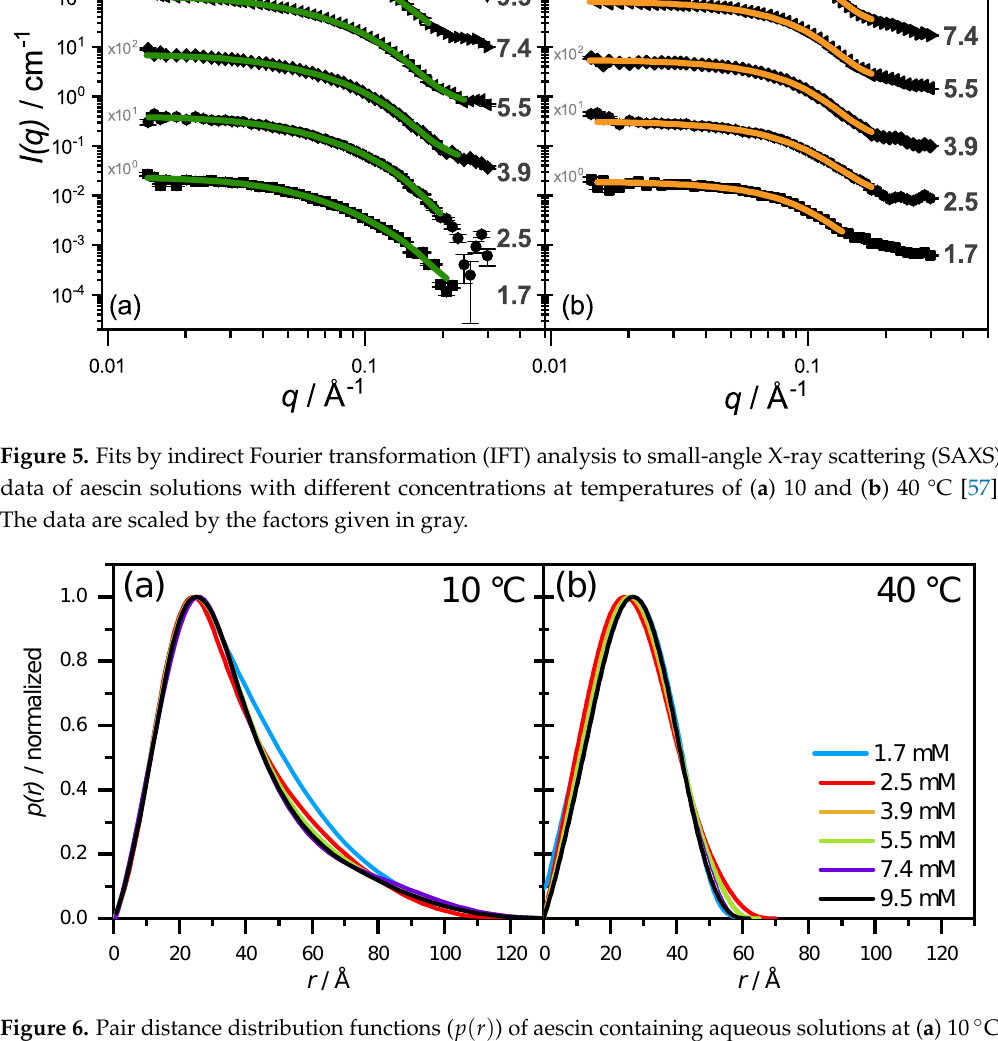
Figure 6. Pair distance distribution functions ( p ( r ) ) of aescin containing aqueous solutions at ( a ) 10 ◦ C and ( b ) 40 ◦ C for different aescin contents. The scattering data were analyzed with the standard IFT method